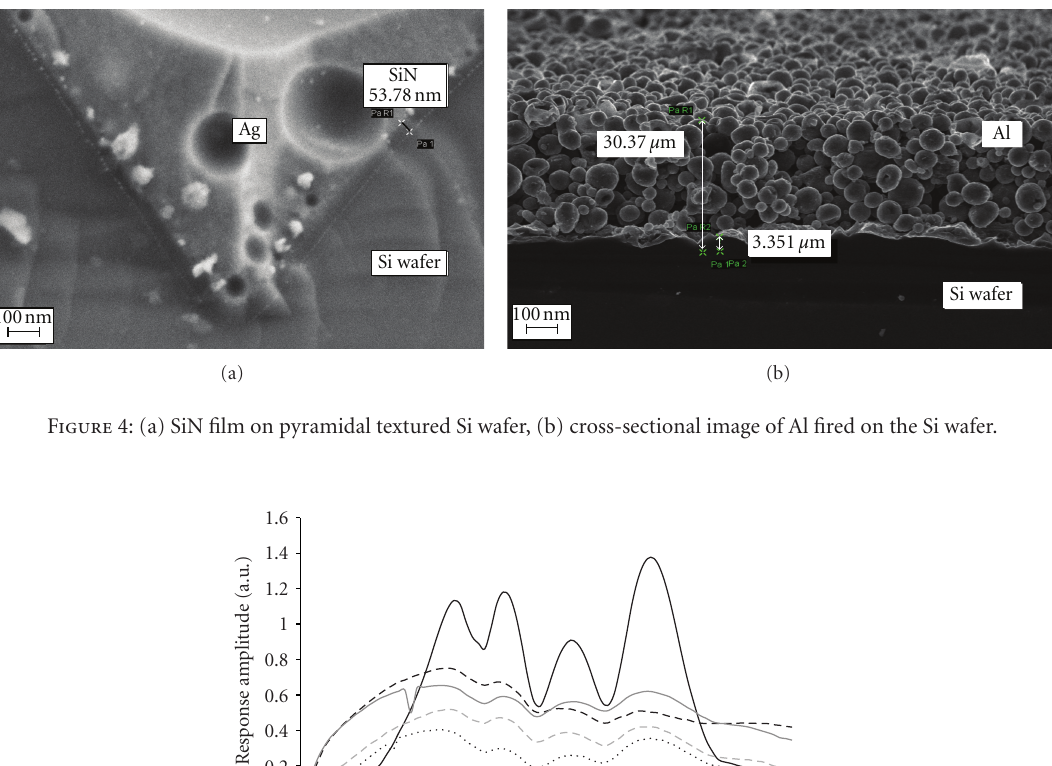
depends on its thickness. This process makes the degradation of thermally grown SiO 2 faster than PECVD-SiO 2 .